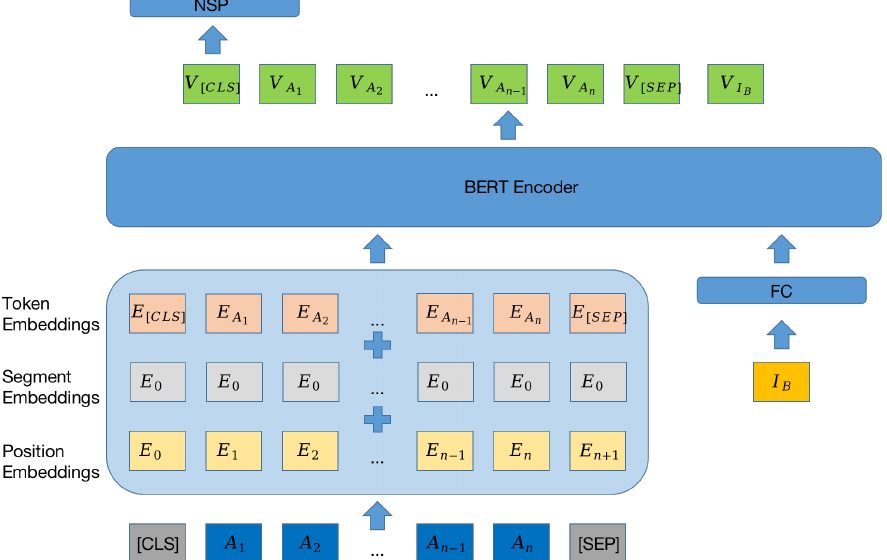
Figure 2. The framework of mixed-modal NSP pre-training. A i means the text token and its embedding is obtained as general BERT. Token embedding is obtained by a bert embedding matrix. Segment embedding marks whether the token belongs to the first or second sentence. Position embedding marks the token’s position.